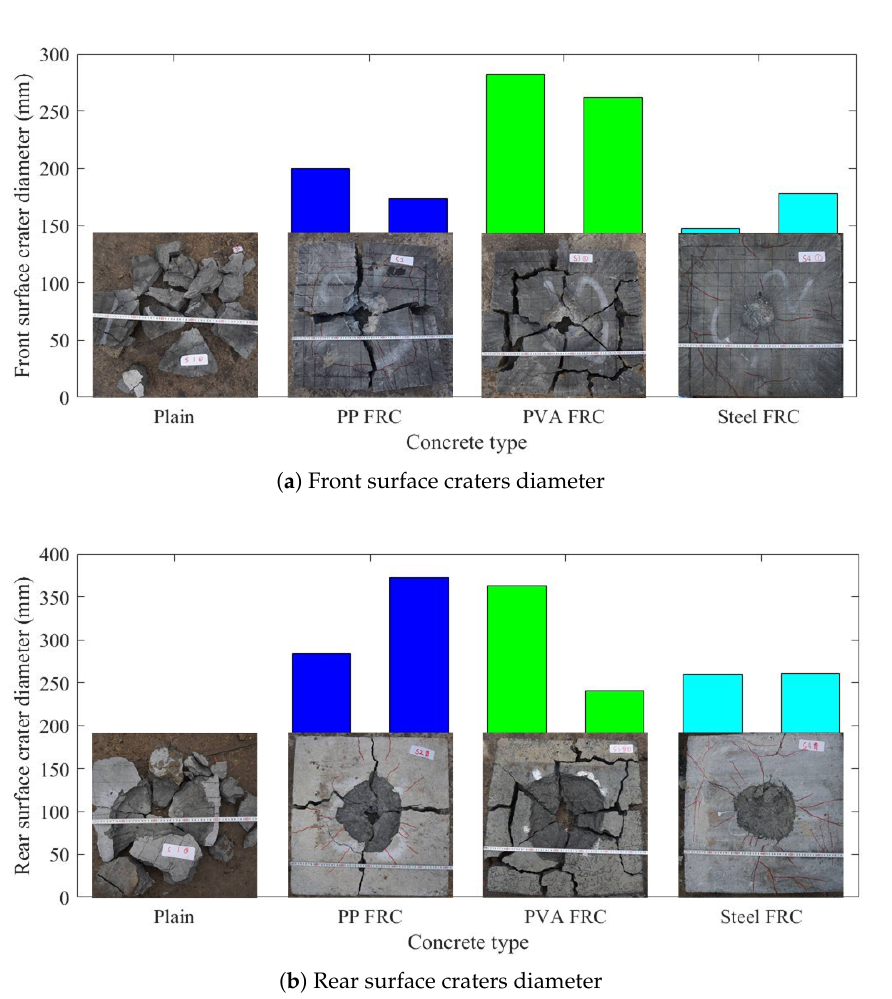
Figure 7. Fiber type effect on panel surface craters.